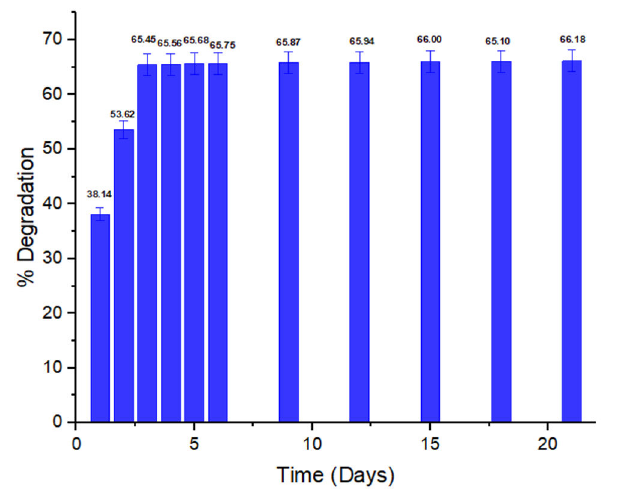
Figure 5. Incubation time (days) impact on % degradation.